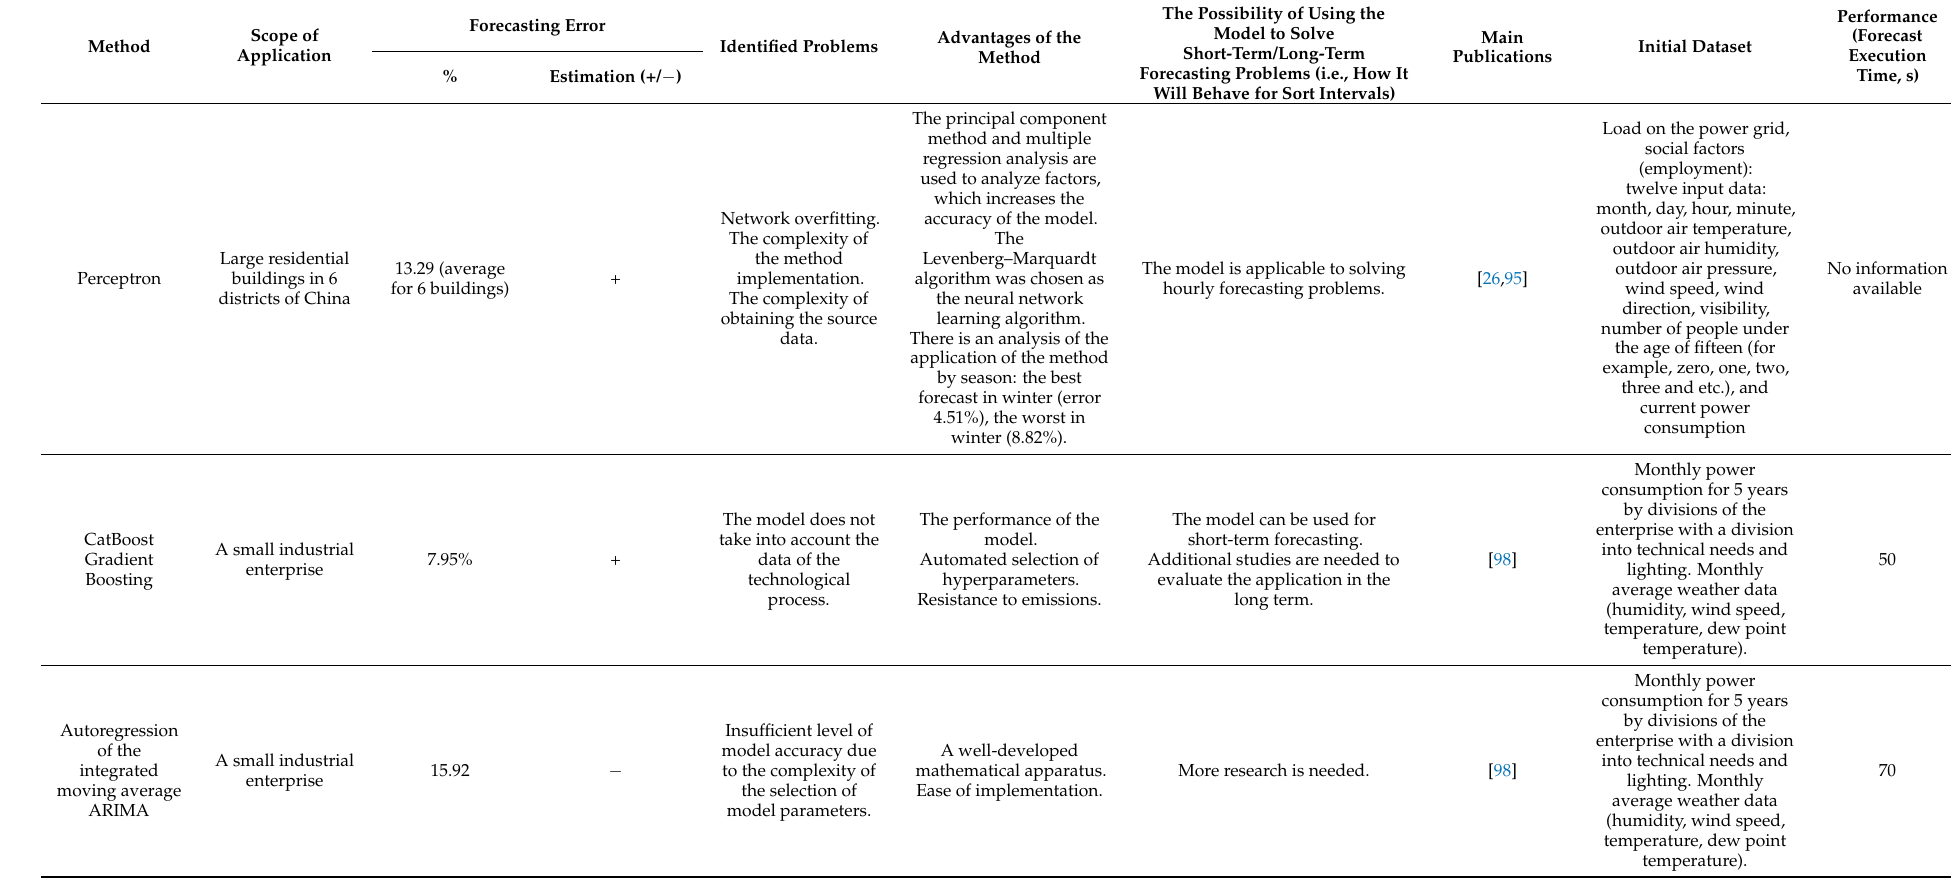
Table 3. Analysis of methods used in the medium-term forecasting of electricity